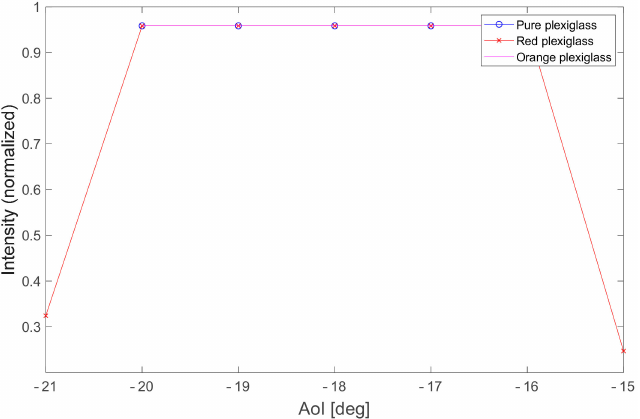
Figure 15. Median values of intensity in measured positions of transparent plastic samples.